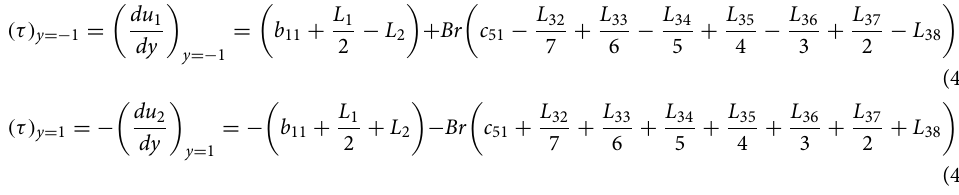
Skin friction: It is friction between the fluid and the surface of a solid for fluid in relative